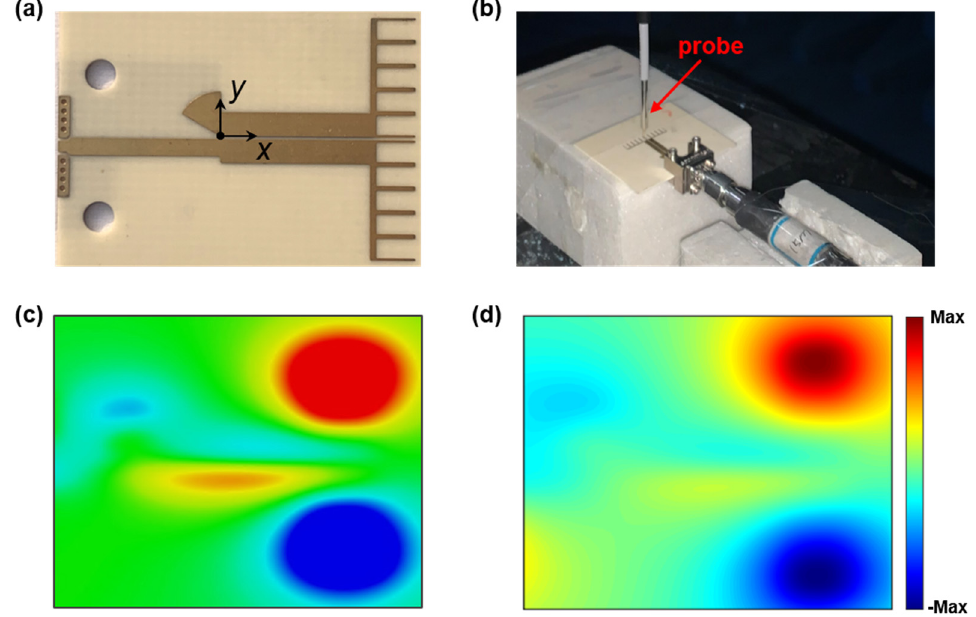
Figure 3. ( a ) Photograph of the sample. ( b ) Photograph of the near-field scanner. Simulated ( c ) and measured ( d ) near-field distribution of the sample at 6 GHz.